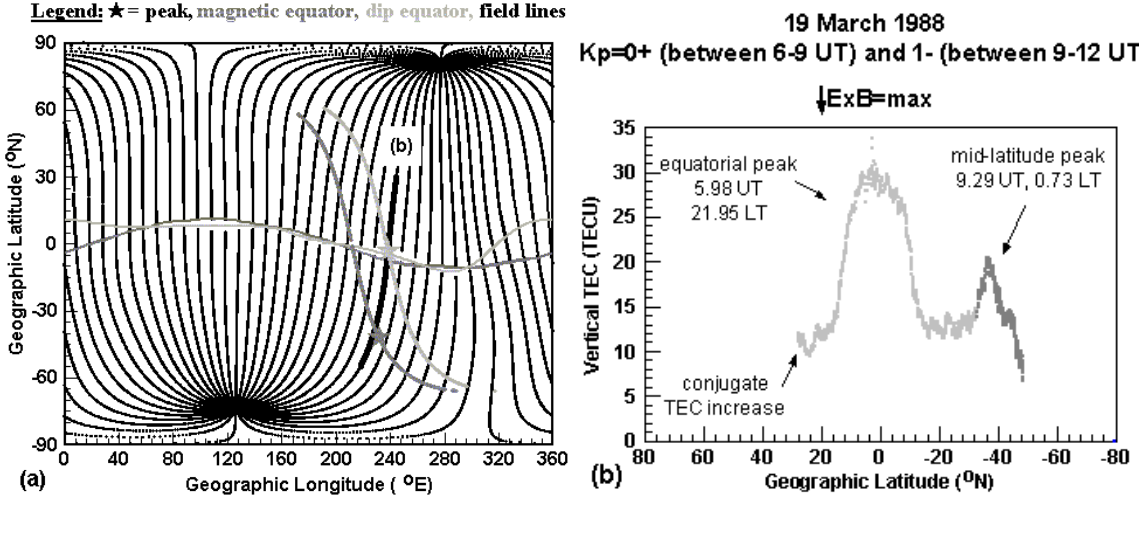
Fig. 7. (a) The ground tracks of the TOPEX passes are plotted with the magnetic field lines to show the field-aligned TOPEX pass. (b) The field-aligned TOPEX TEC cross section depicts the symmetric equatorial peak at maximum downward drift and the mid-latitude night-time TEC increases in magnetic